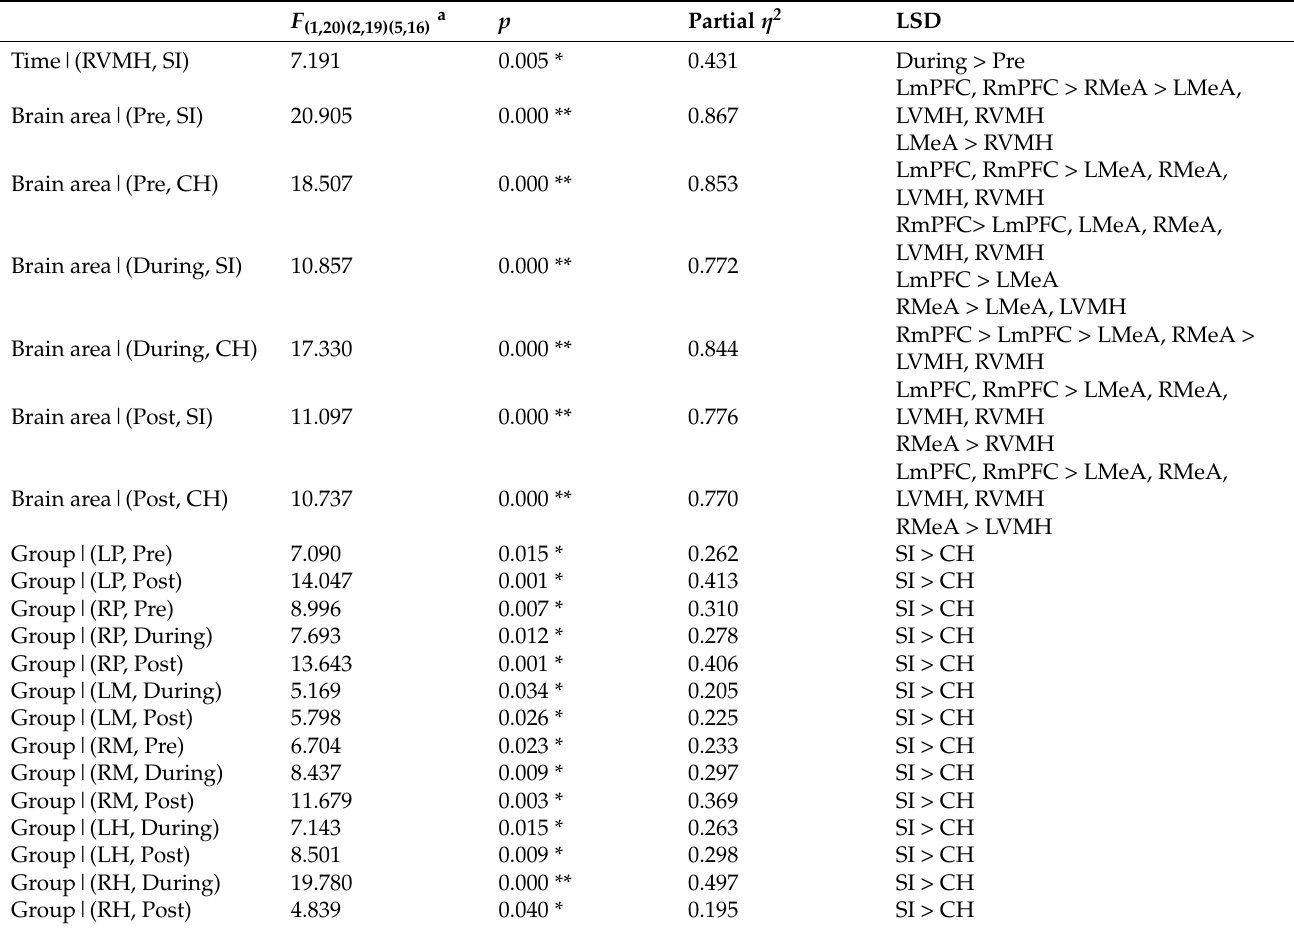
Table 2. Results of simple-simple effects analysis for the interaction among the factors “group”, “time condition” and “brain area” for the gamma